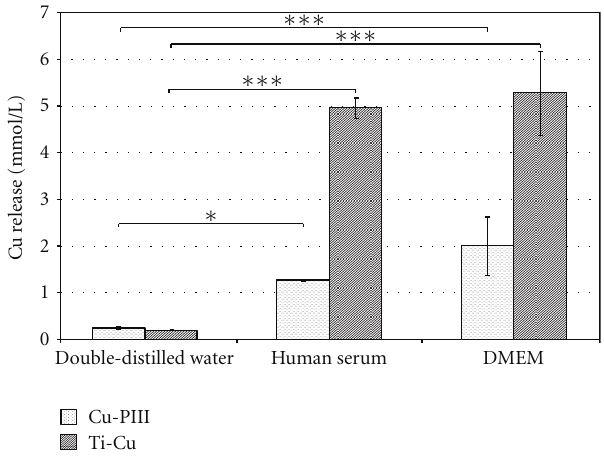
Figure 1: Copper concentration of Cu-PIII- and Ti-Cu-coated corundum-blasted Ti6Al4V surfaces submersed in 700 μ L of dif- ferent supernatants (human serum, double-distilled water, and DMEM) for 24h at 37 ◦ C and 5% CO 2 ; ANOVA (Post Hoc LSD) test, ∗ P < 0 . 05, ∗∗∗ P ≤ 0 . 001.